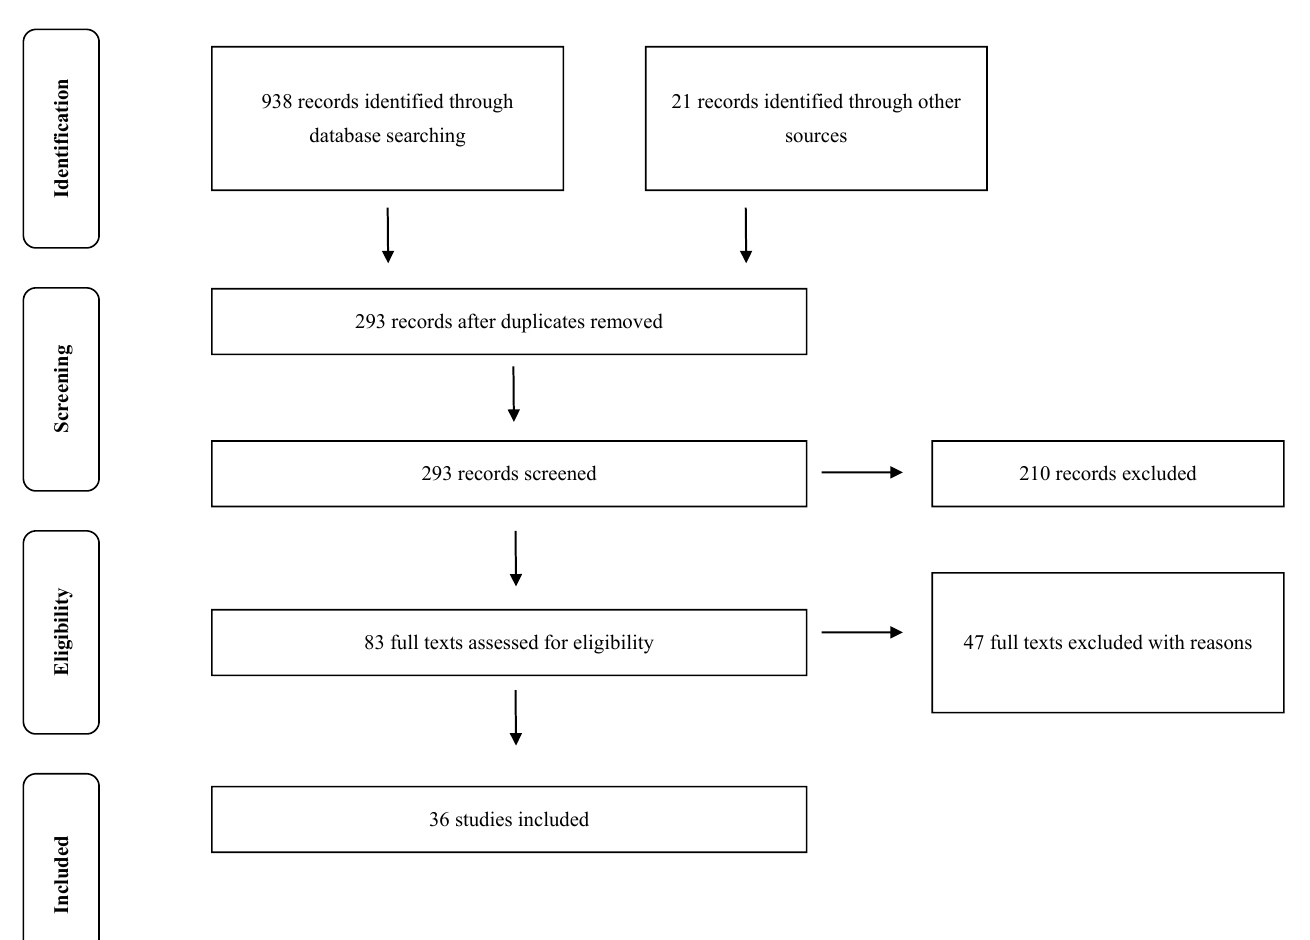
Figure 1. Preferred reporting items for systematic reviews and meta-analyses flow diagram of study